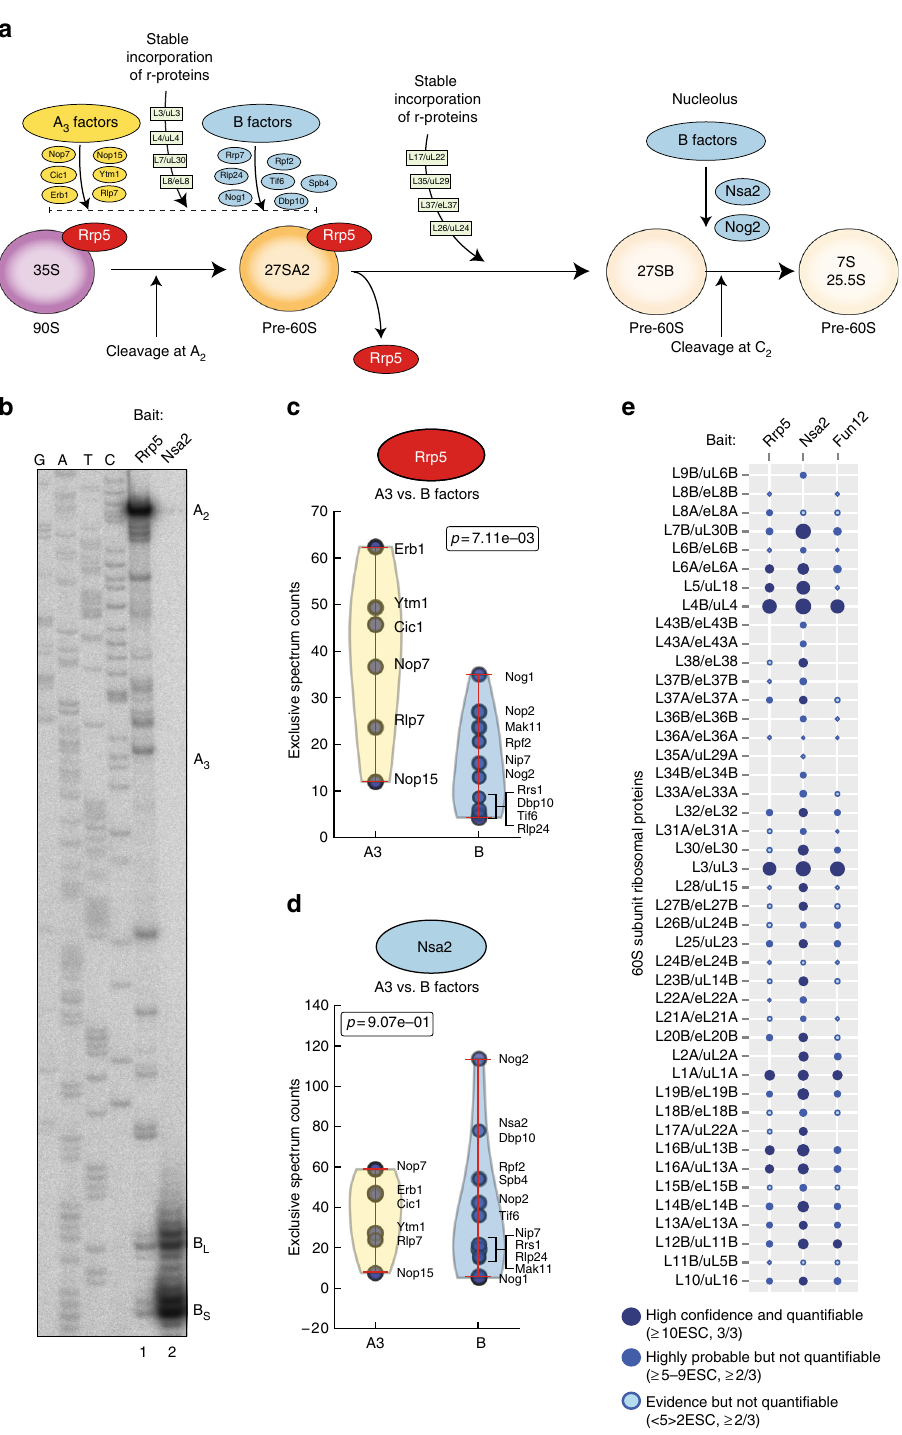
NATURE COMMUNICATIONS | DOI: